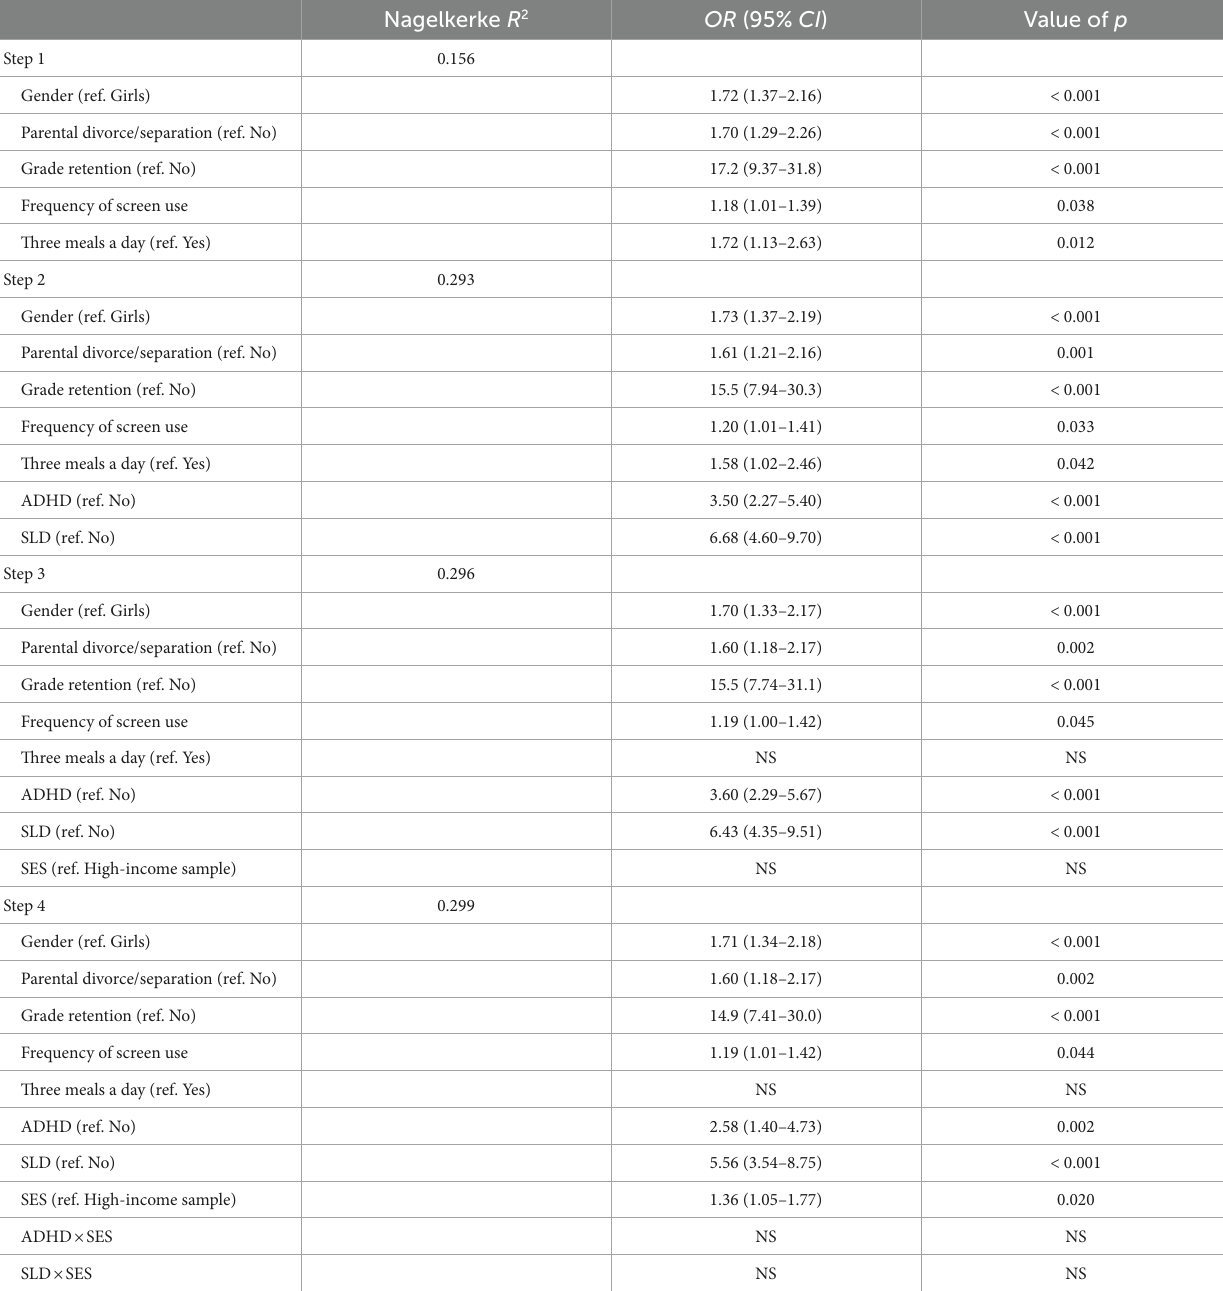
TABLE 5 Predictors of poor academic performance on foreign